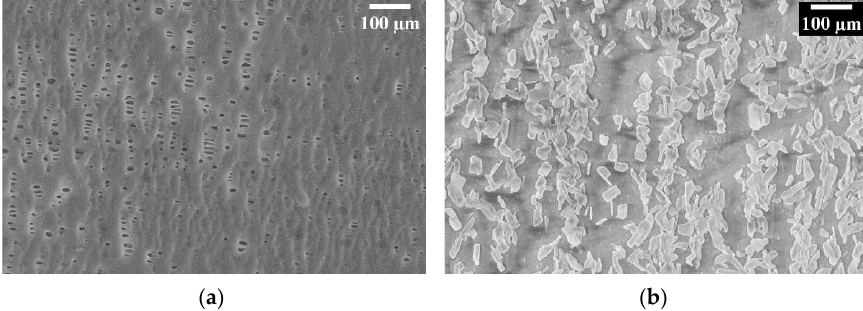
Figure 5. SEM image of Celgard 3401, ( a ) before activation ( b ) after activation with Fumion.